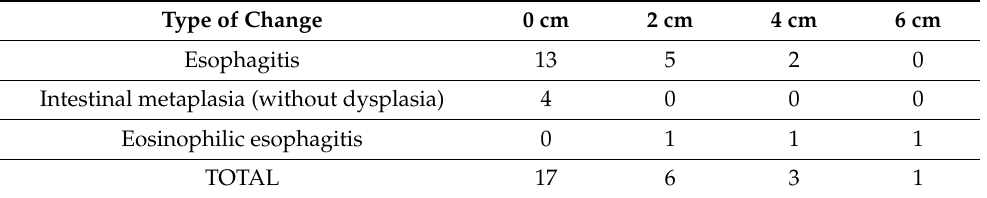
Table 9. Results of histopathologic assessment of the collected bioptats of the esophageal